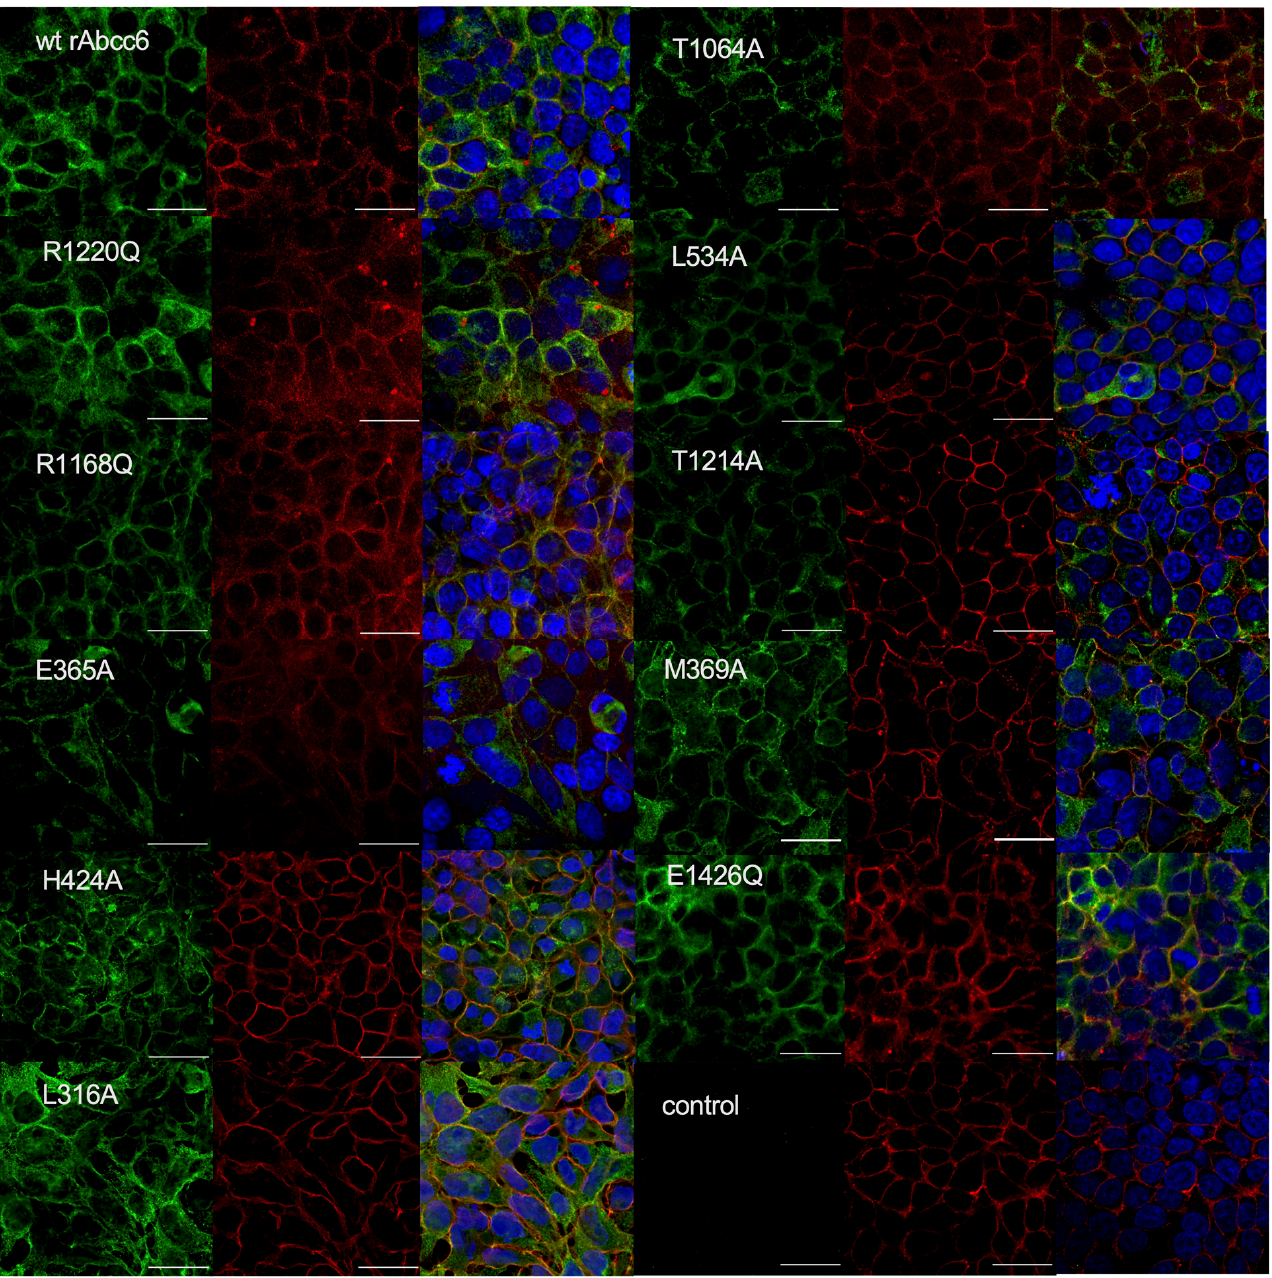
Figure 6. Subcellular localization of rAbcc6 mutants with reduced ATP efflux activity. Representative images of